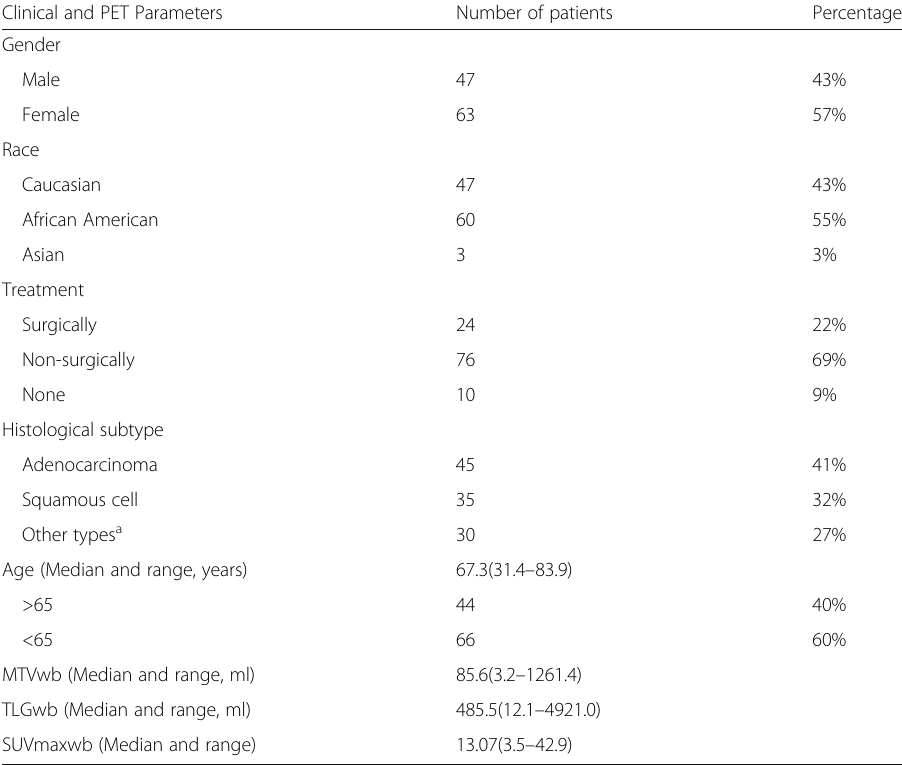
Table 1 Characteristics of patients from the University of Chicago Clinical and PET Parameters